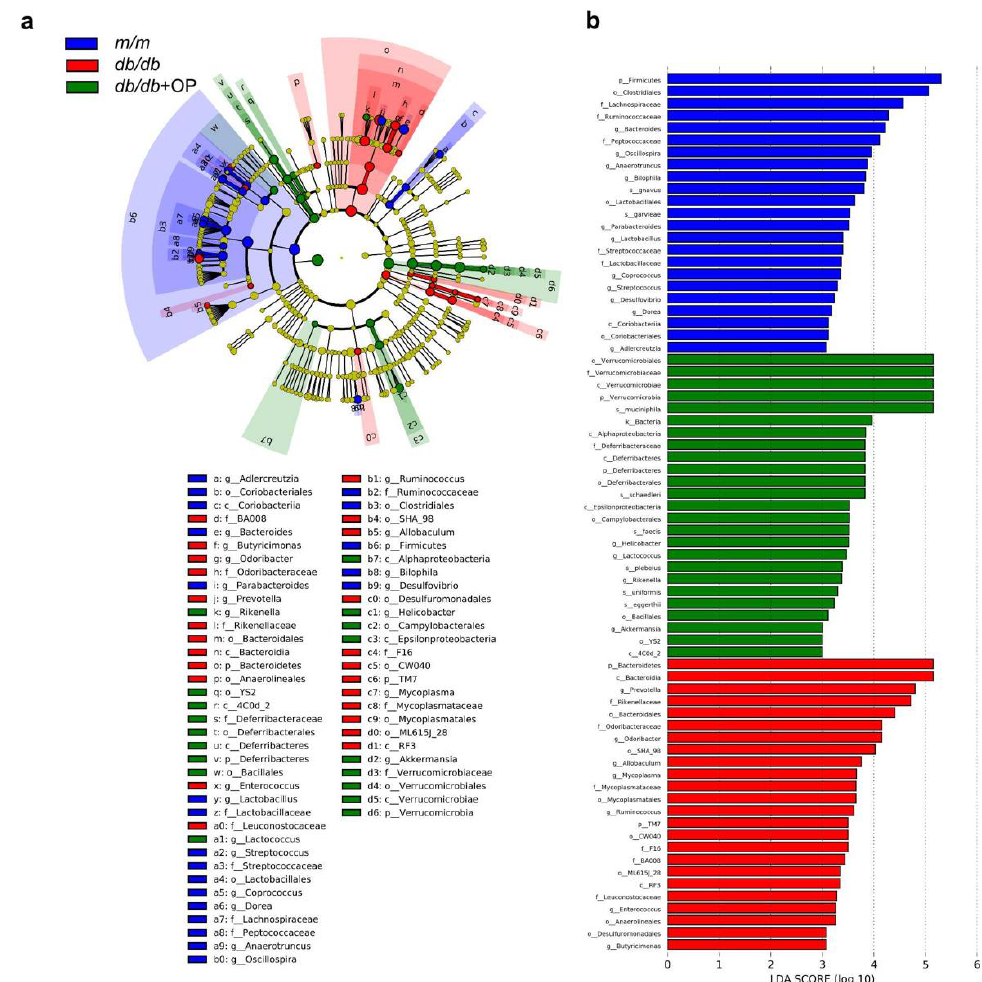
Figure 6. Key phylotypes of intestinal flora responding to OP treatment. ( a ) LEfSe analysis showed the relationship of OTUs (the rings, from outer to inner, represent genus, family, order, class, and phylum); ( b ) Comparison of intestinal flora among m / m group mice, db / db group mice, and db / db + OP group mice with LDA score > 3.